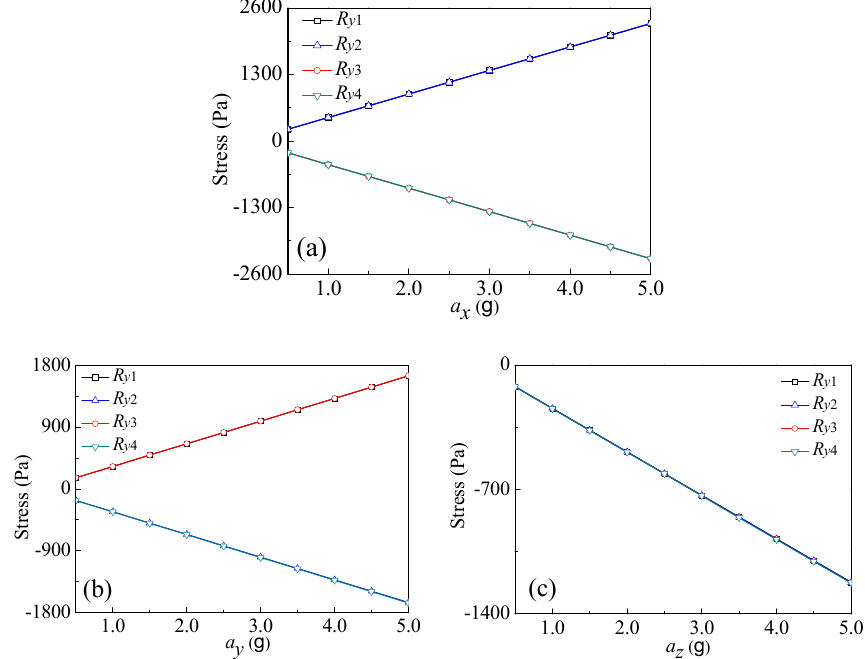
Figure 4. Relationship curves between the stress of L-shaped beams’ root along y -axis and applied acceleration: ( a ) a = a x ; ( b ) a = a y ; and ( c ) a = a z .